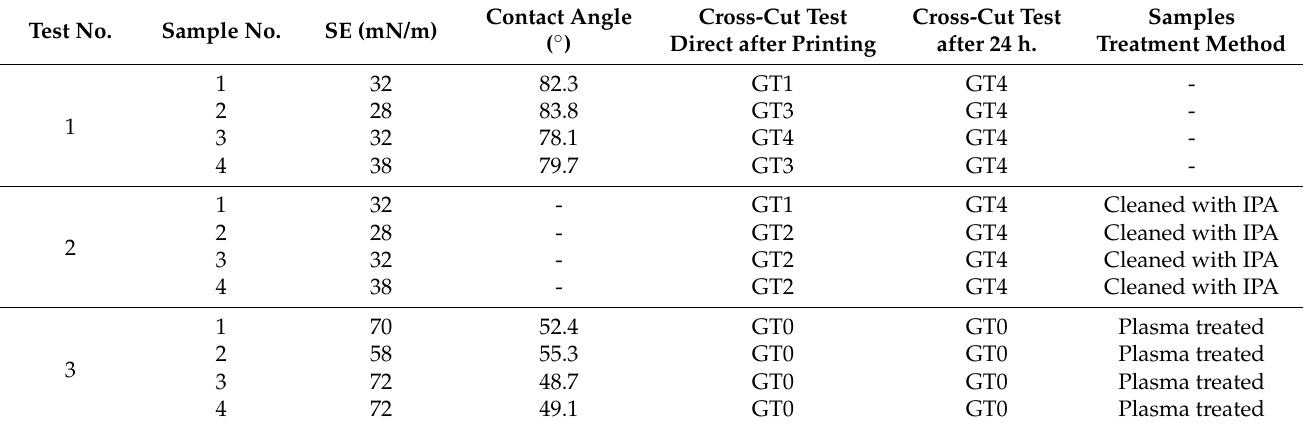
Table 4. Experiment results.